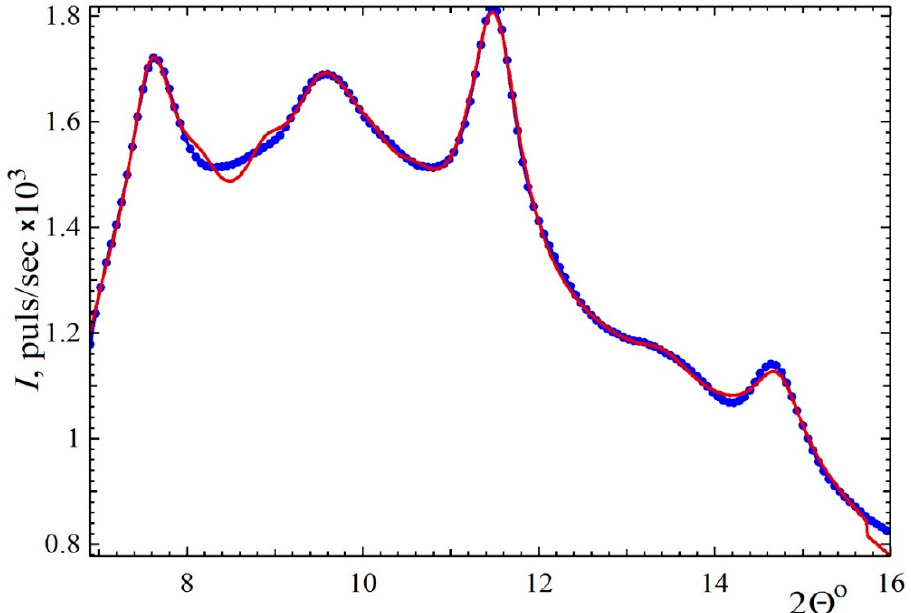
Figure 4. Result of cell parameter determination using the FullProf package. Dots: experimental data; line: fit by monoclinic Pm/2 model.